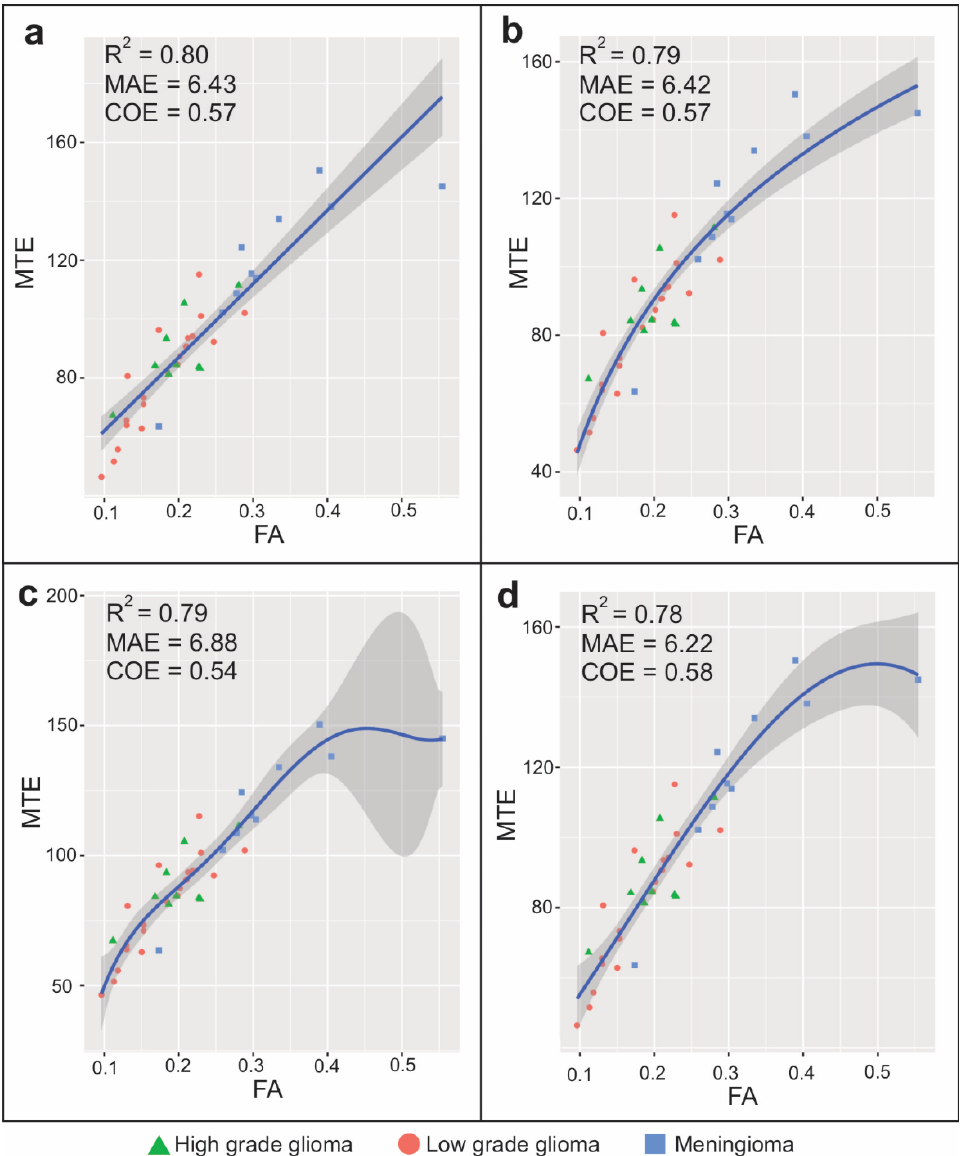
Figure 5. Model fit represented by scatterplots of ( a ) linear, ( b ) logarithmic, ( c ) quadratic polynomial, and ( d ) cubic spline regressions. The Y-axis shows the mean tissue elasticity as the dependent variable and the X-axis shows fractional anisotropy values as the predictor. Gray zone represents a 95% confidence interval. In the left upper corner of each model, the adjusted R 2 , mean absolute error (MAE), and coefficient of efficiency (COE) are shown. Cases are presented by histopathologic groups detailed in the legend at the bottom of the